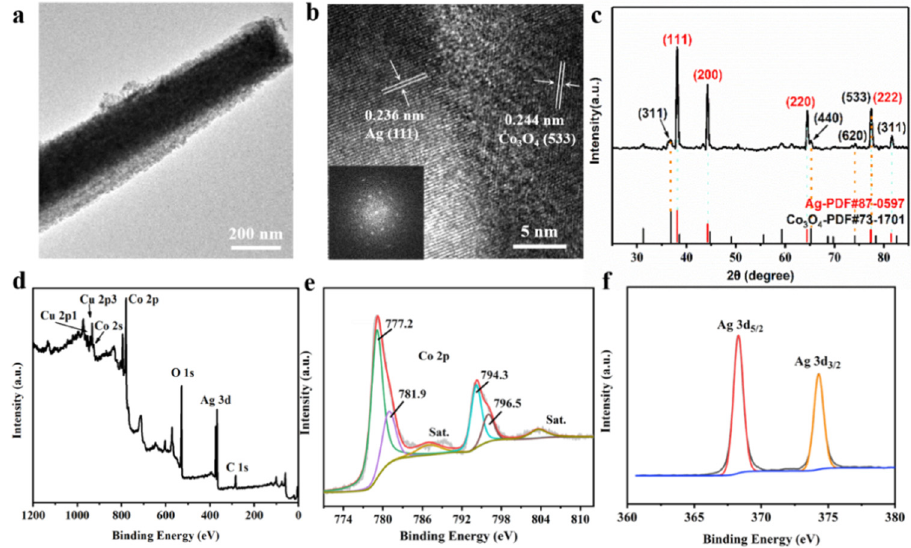
Figure 2. Material characterizations of the Cu@Co 3 O 4 @Ag-H substrates. ( a ) TEM image of single Co 3 O 4 NW@Ag-H. ( b ) HRTEM image and SAED pattern of Co 3 O 4 NW@Ag-H. ( c ) XRD pattern of Co 3 O 4 NW@Ag-H.